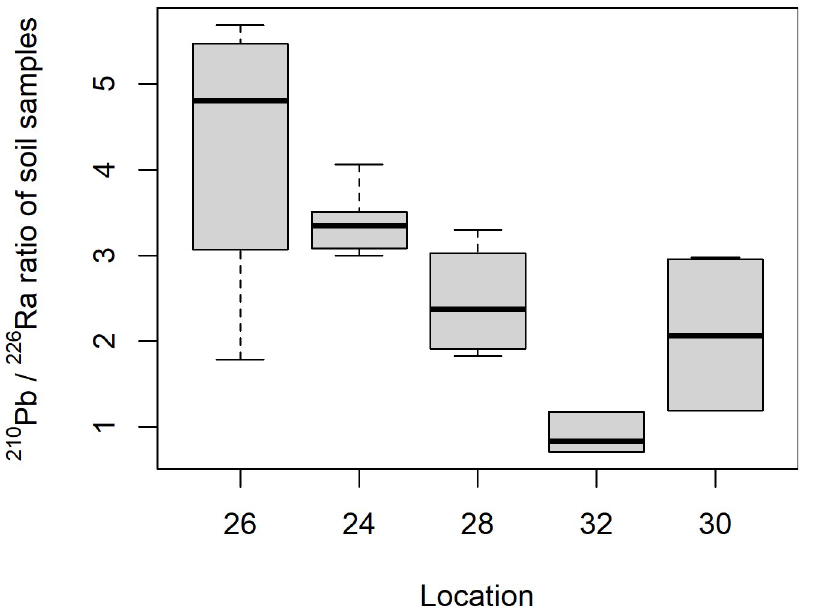
Fig 9. Boxplot of 210 Pb to 226 Ra ratio of soil samples among localities within Mining hill.